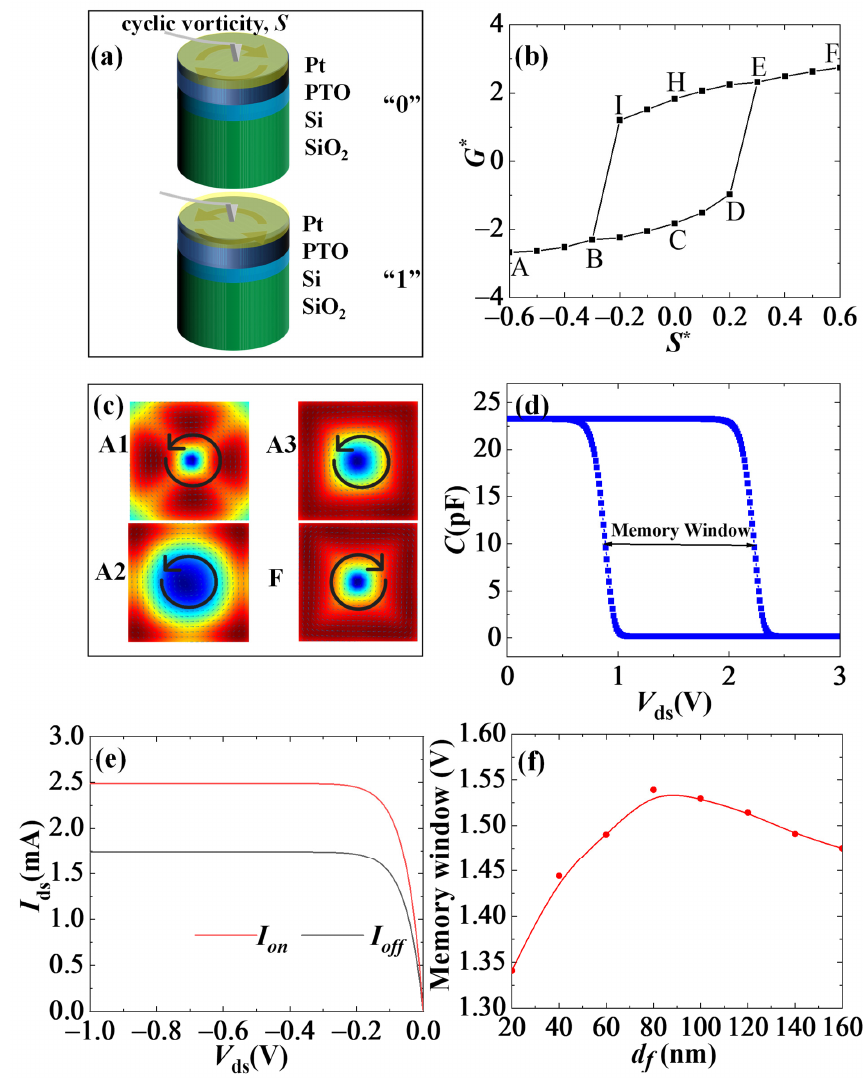
Figure 1. ( a ) Schematic diagram of the ferroelectric topology domain transistor structure. ( b ) Hys- teresis loop between the toroidal moment G * and vorticity S * at room temperature (A-I is the loading point corresponding to S * ). ( c ) A1, A2, and A3 are 500 steps, 5000 steps, and 10,000 steps at point A, respectively, and F shows the ultimate domain structure at point F. ( d ) C-V ds . (e) I ds -V ds . ( f ) Memory window for different PTO thicknesses. The superscript * indicates the corresponding dimensionless posterior parameter.